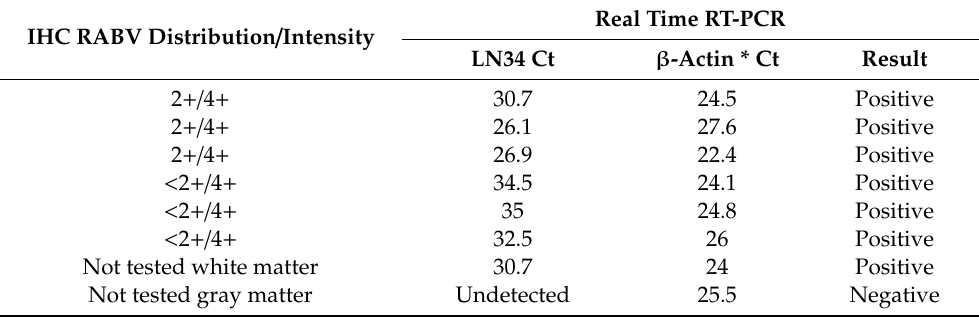
Not tested white matter Not tested gray matter Undetected 25.5 Negative * qPCR assay measures host RNA